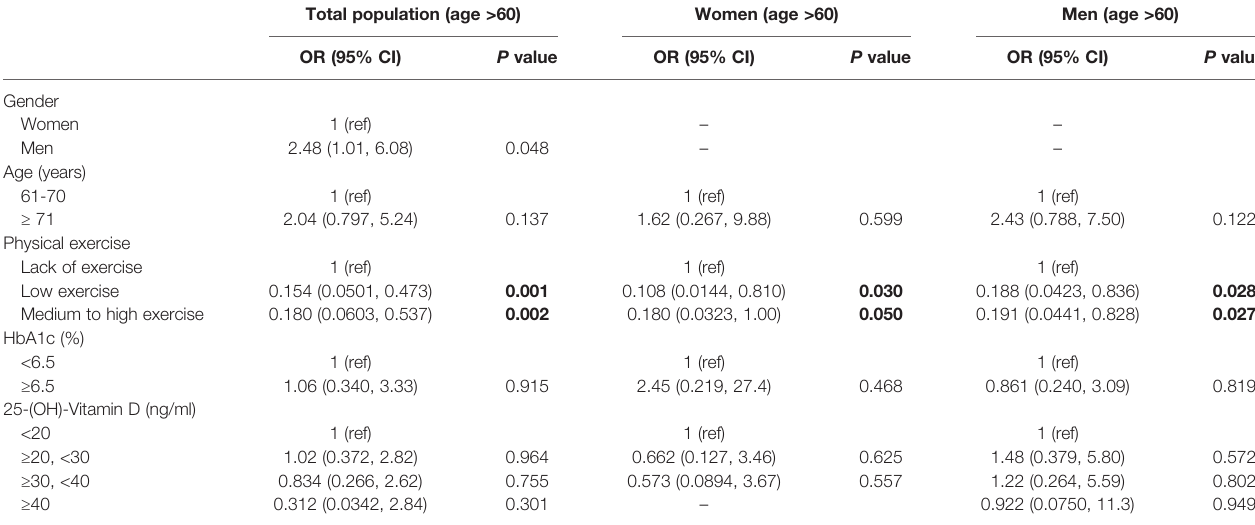
TABLE 5 | Factors associated with very low NKA < 100 pg/mL compared to normal NKA ≥ 500 pg/mL in subjects with age >